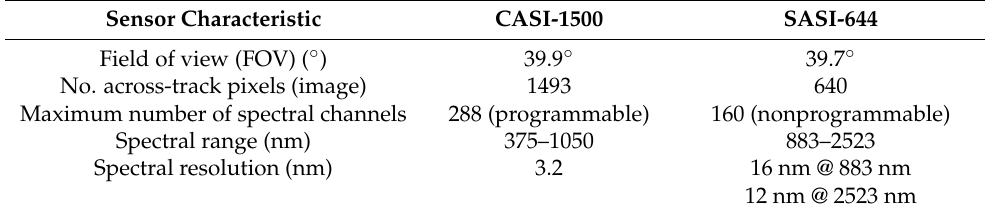
Table 1. Characteristics of CASI-1500 and SASI-644 Sensors used in the Mission Airborne Carbon 2013 (MAC13) project for collecting HSI over the study area.